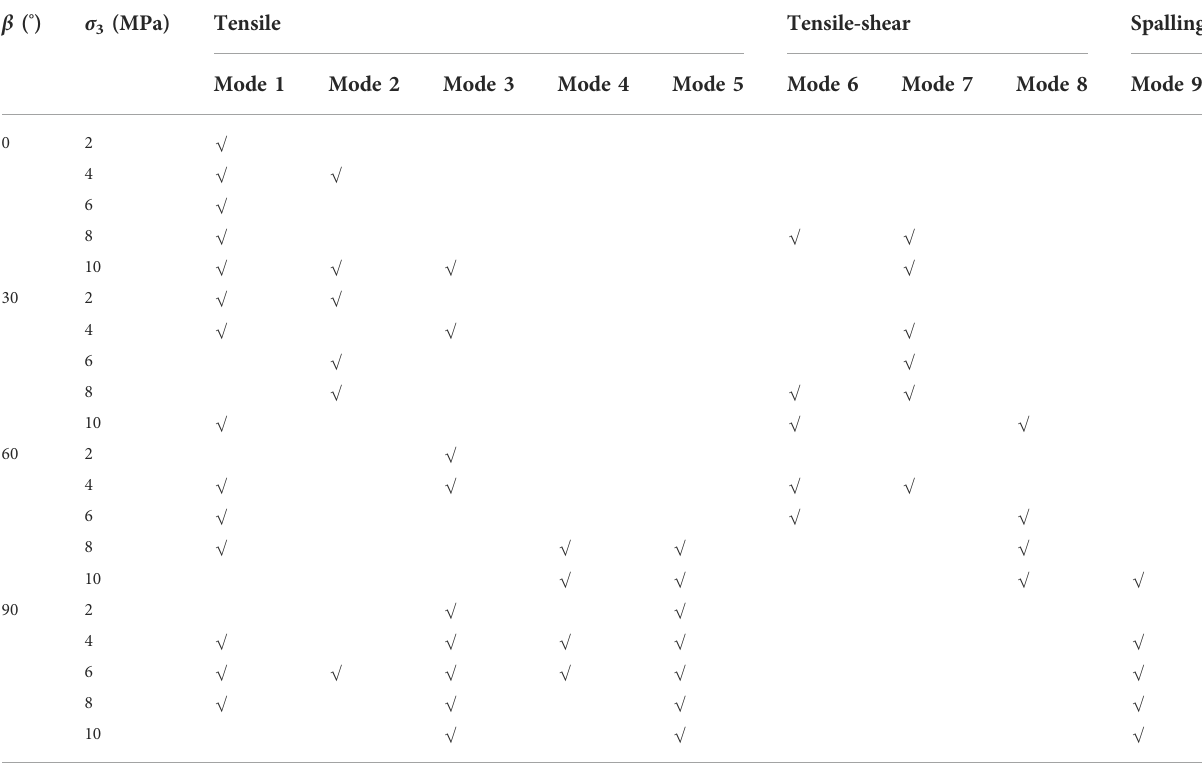
Crack types found in samples are marked with “ √ . ”